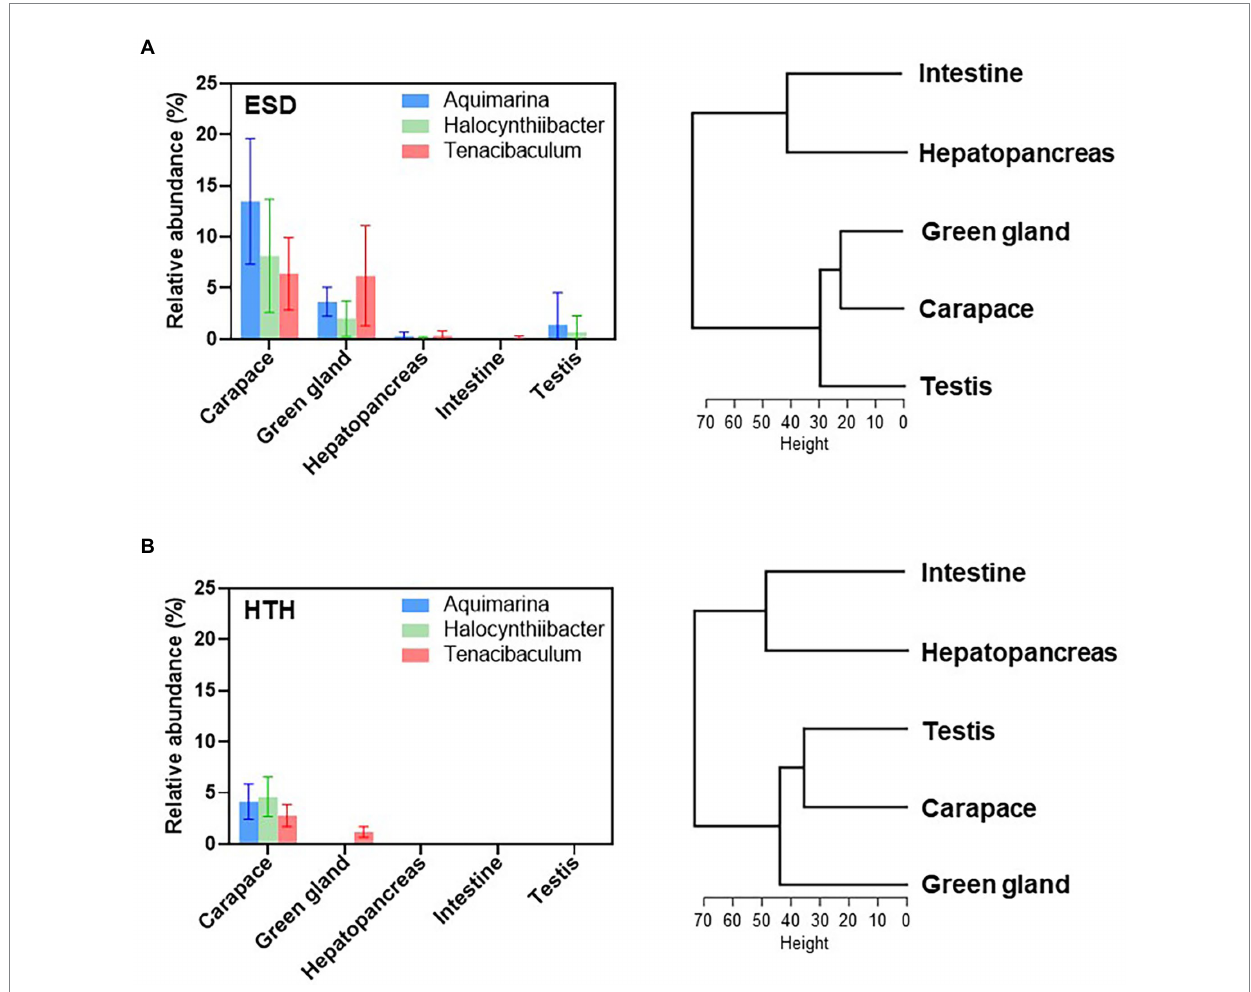
FIGURE 5 Effects of carapace bacteria on the internal tissues. Relative abundances of ESD-related core carapace bacteria ( Aquimarina , Halocynthiibacter, and Tenacibaculum ) across the carapace, green gland, hepatopancreas, intestine, and testis of (A) lobsters with ESD and (B) healthy lobsters. The bars represent the means and their standard errors. Hierarchical clustering analysis of five tissues based on the genus abundance data was conducted using the R function